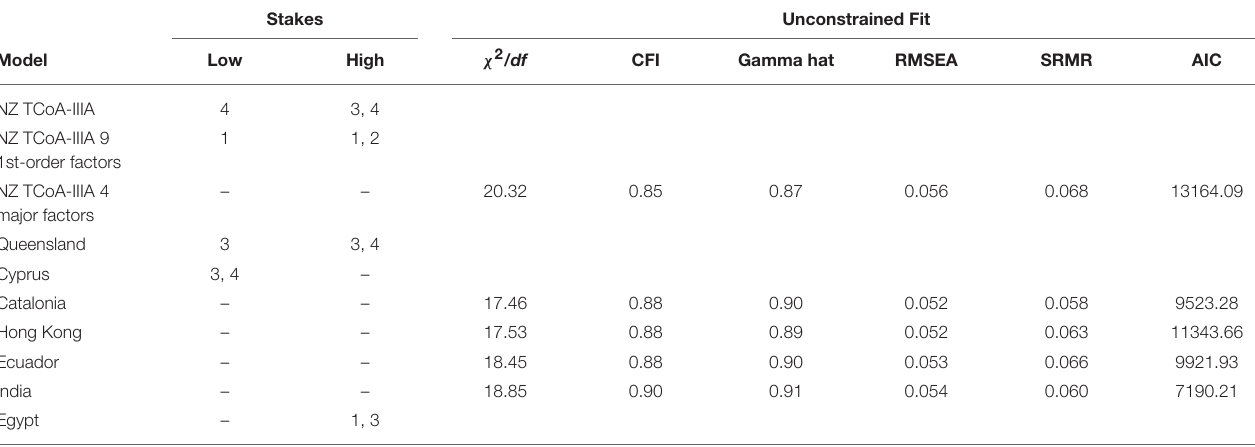
TABLE 4 | Model admissibility by overall stakes with unconstrained fit statistics for admissible models.